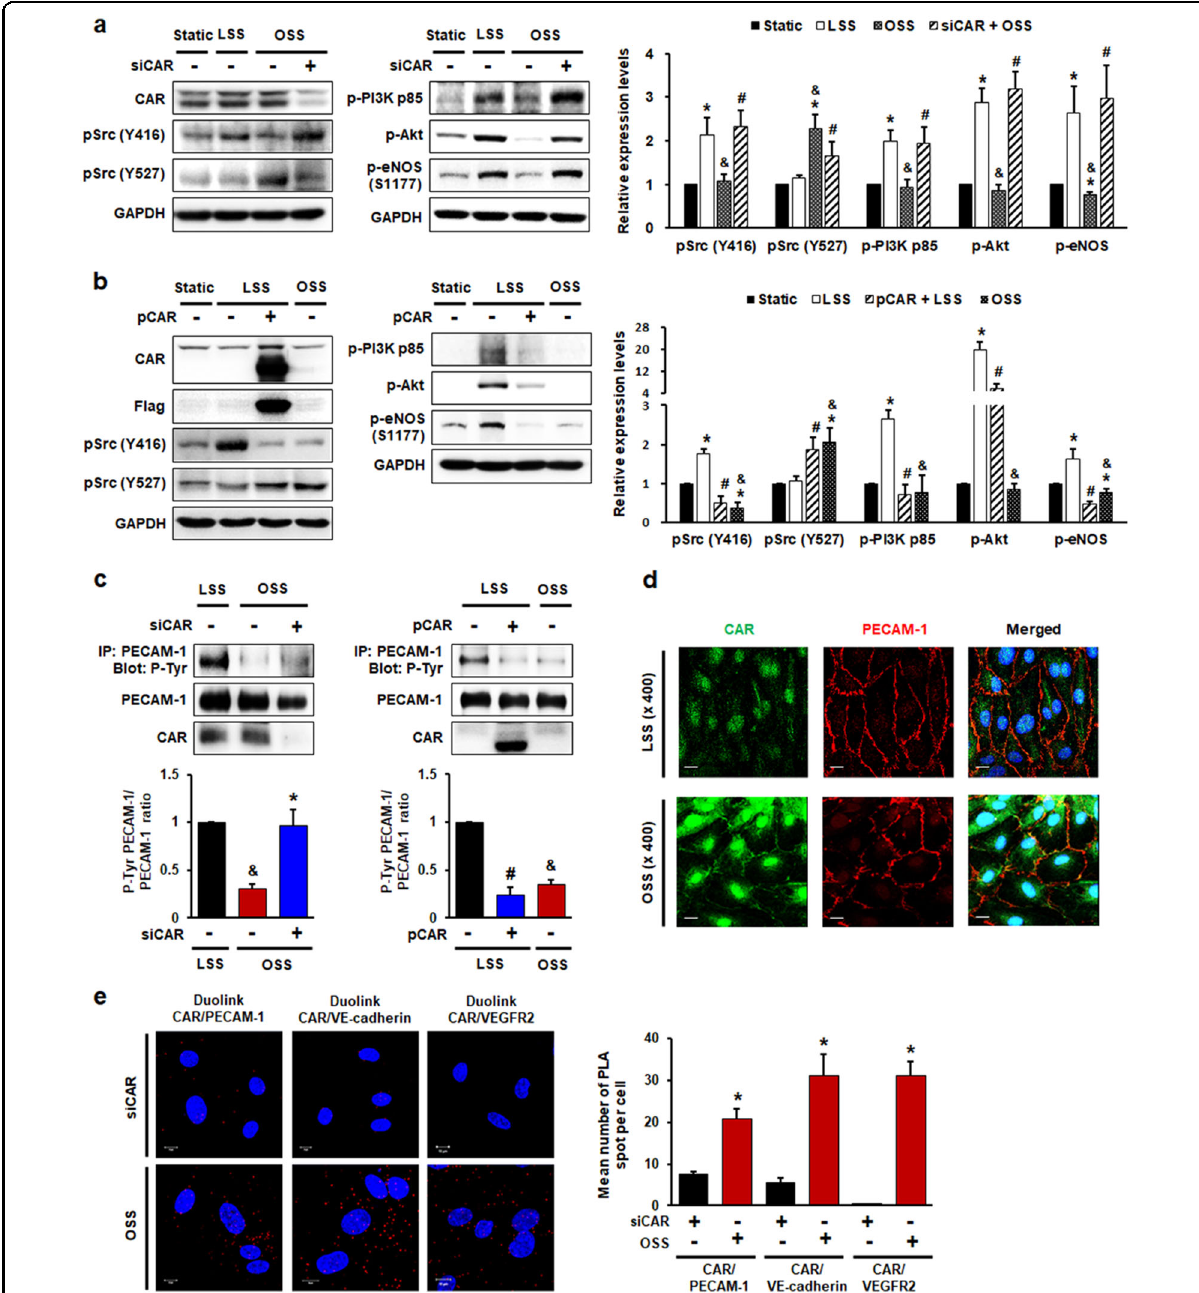
Fig. 5 CAR acts as a mechanotransduction modulator in endothelial cells under disturbed fl ow. HUVECs transfected with siRNA ( a , c , e ) against CAR or fl ag-tagged plasmid ( b , c ) encoding CAR were exposed to FSS. The phosphorylation of Src at Y416 (active form) and Y527 (inhibitory form), PI3K, Akt, and eNOS (S1177) was assessed. Representative images from at least fi ve experiments are shown. a n = 5; * P < 0.05, static vs. LSS or OSS; & P < 0.05, LSS vs. OSS; # P < 0.05, OSS vs. siCAR + OSS. b n = 5; * P < 0.05, static vs. LSS or OSS; & P < 0.05, LSS vs. OSS; # P < 0.05, LSS vs. pCAR + LSS. c Transfected HUVECs exposed to FSS for 10 min were immunoprecipitated with anti-PECAM-1 antibody. The tyrosine phosphorylation of PECAM-1 was assessed in PECAM-1 immunoprecipitates by western blotting ( n = 5; & P < 0.05, LSS vs. OSS; * P < 0.05, OSS vs. siCAR + OSS; # P < 0.05, LSS vs. pCAR + LSS). d Colocalization of CAR with PECAM-1 was visualized by confocal microscopy. Representative images from at least three experiments are shown (green, CAR; red, PECAM-1; blue, nuclei; scale bars, 10 μ m). e The association between CAR and the mechanosensory complex (VEGFR2, VE- cadherin, and PECAM-1) in HUVECs exposed to disturbed fl ow was determined by PLA. Cells transfected with siCAR were used as a negative control. Red spots indicate interactions between CAR and the mechanosensory complex. Red spots were enumerated to quantify the number of in situ PLA signals per cell. Representative images are shown ( n = 5; compared with siCAR, * P < 0.05; scale bars, 10 μ